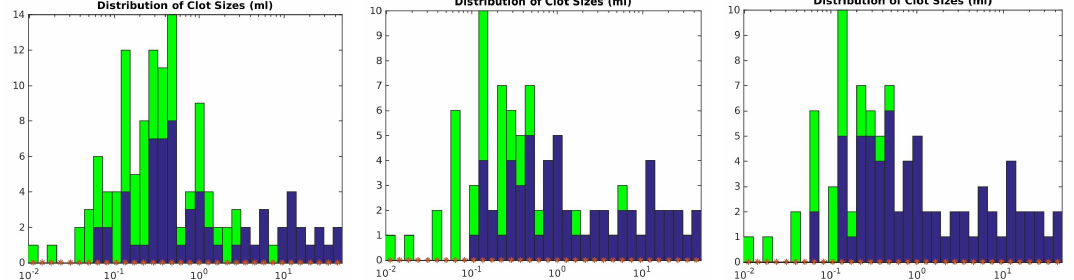
Figure 5. Histograms of emboli volumes shown in green with detected emboli shown in blue for the three proposed methods: ( Left ) the 2 D network; ( Middle ) the 2.5 D network; and ( Right ) the 3 D network. The more complex is the network, the more consistently it detected emboli. All methods found it difficult to detect small emboli (less than 0.5